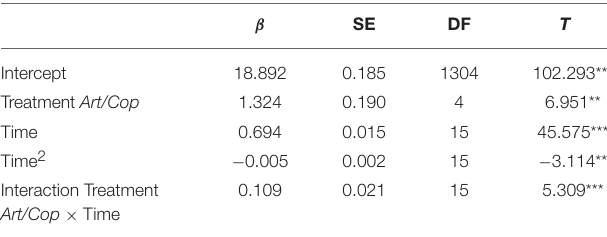
TABLE 2 | Linear mixed-effect explaining height of Hippocampus reidi larvae depending on two dietary treatments.